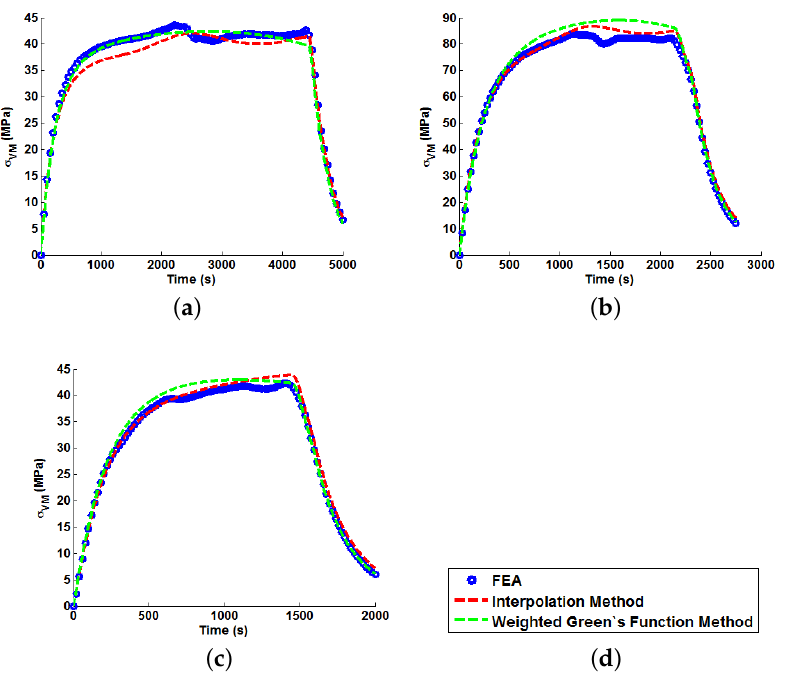
Figure 11. Predictions of thermal stress responses determined using the interpolation and weighted Green’s functions methods for: ( a ) ramp up Profile A; ( b ) ramp up Profile B; and ( c ) ramp up Profile C. Sub figure ( d ) shows the legend used in the